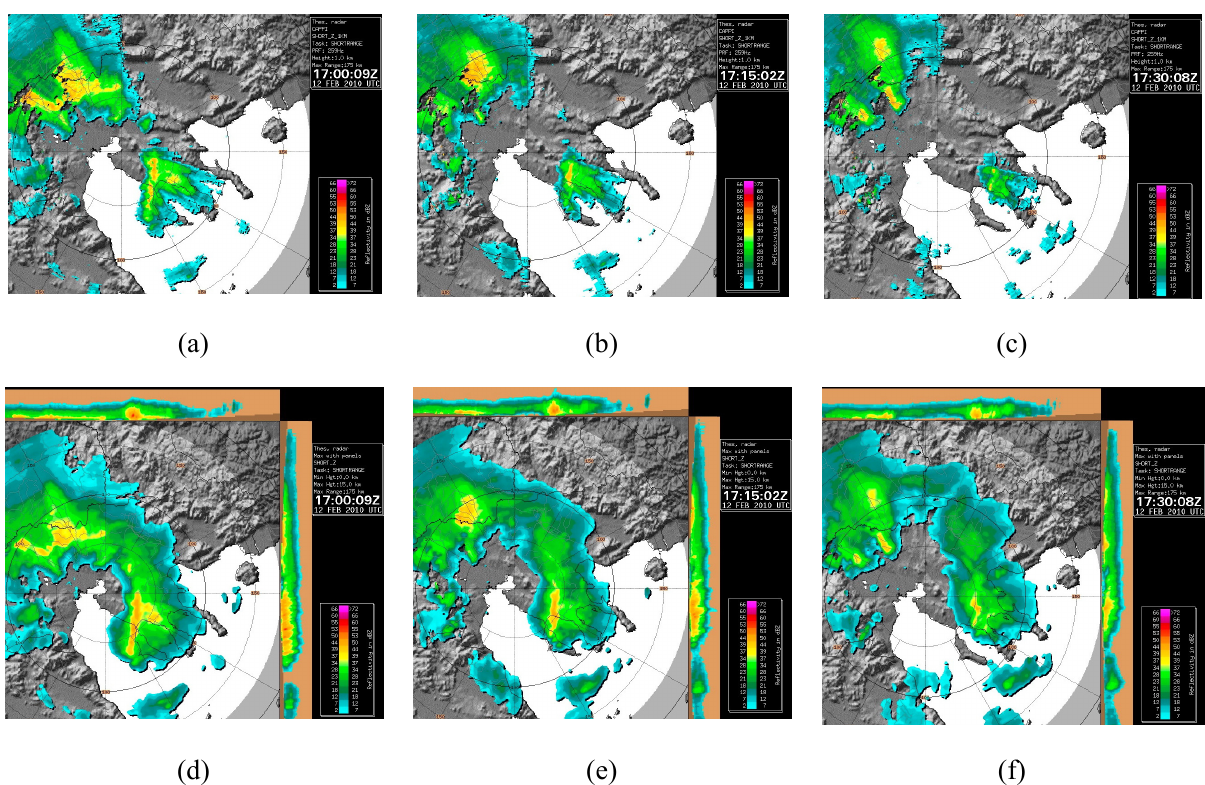
Figure 3. Radar images from LGTS Radar: CAPPI at 1km height in 15min time step (a–c) and MAX (MAXimum Reflectivity) in 15min time step (e–f) .